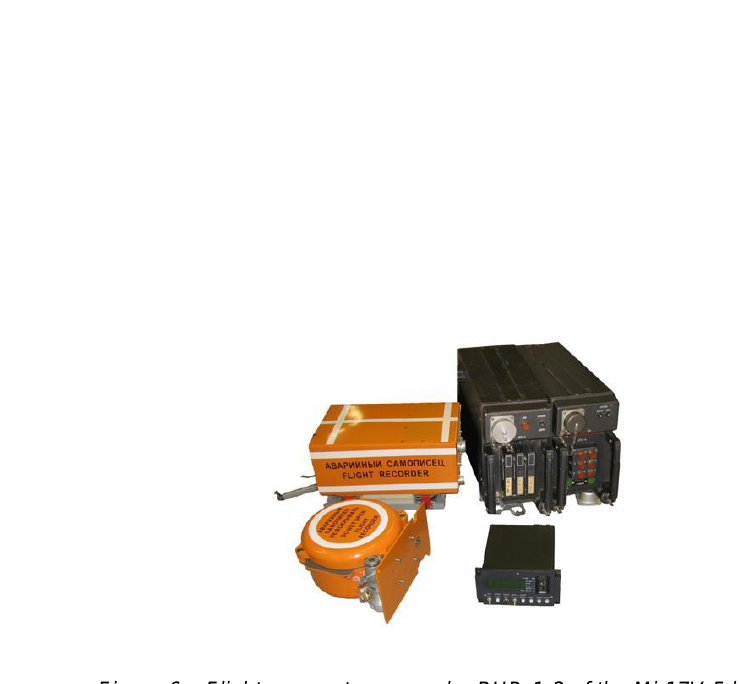
Figure 6 – Flight parameters recorder BUR-1-2 of the Mi-17V-5 helicopter Рис. 6 – Регистратор параметров полета БУР-1-2 вертолета Ми-17В-5 Слика 6 – Регистратор параметара лета БУР-1-2 хеликоптера Ми-17В-5